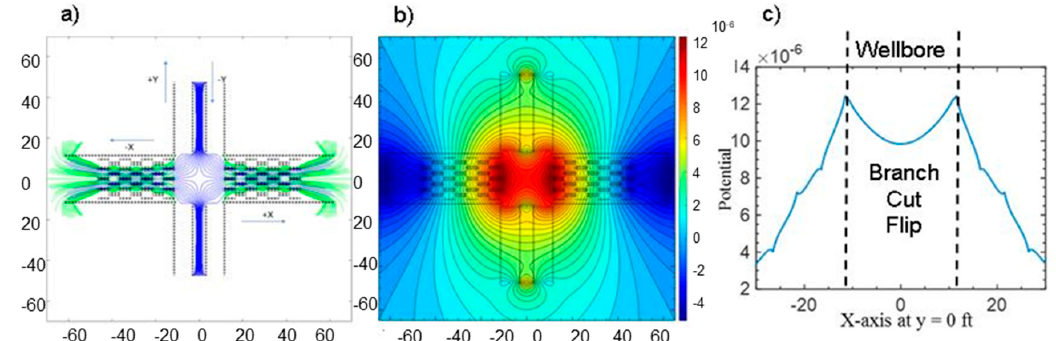
Figure 9. Injection well. ( a ) Blue streamlines are for fluid from the wellbore invading the reservoir space. Green streamlines are for fluid originally in the reservoir and displaced by the wellbore fluid. The result is obtained by solving the stream function of the composite flow field. ( b ) Pressure field obtained by solving the corresponding potential function scaled in units of cm 2 s − 1 (Case 5, Table 1). ( c ) Dynamic BHP pressure profile (along vertical axis in cm 2 s − 1 ) at reservoir–wellbore transition. Length units are scaled in cm (both x-axis and y-axis).